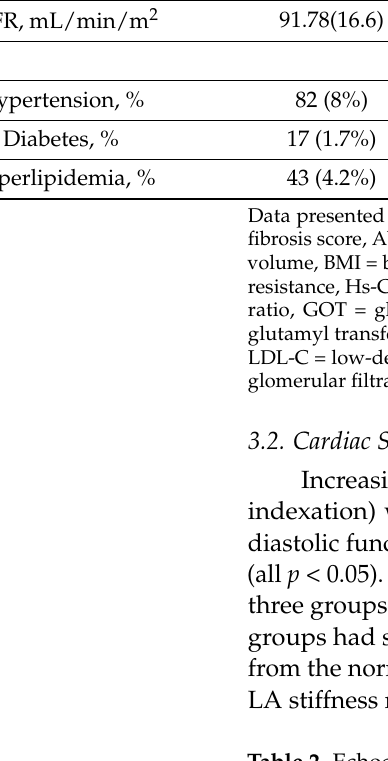
Table 2. Echocardiographic